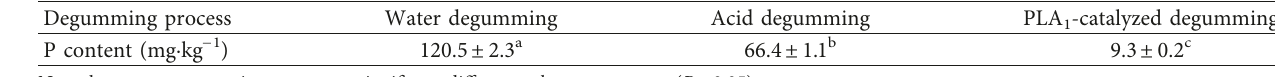
Table 1: Effect of degumming methods on P content.